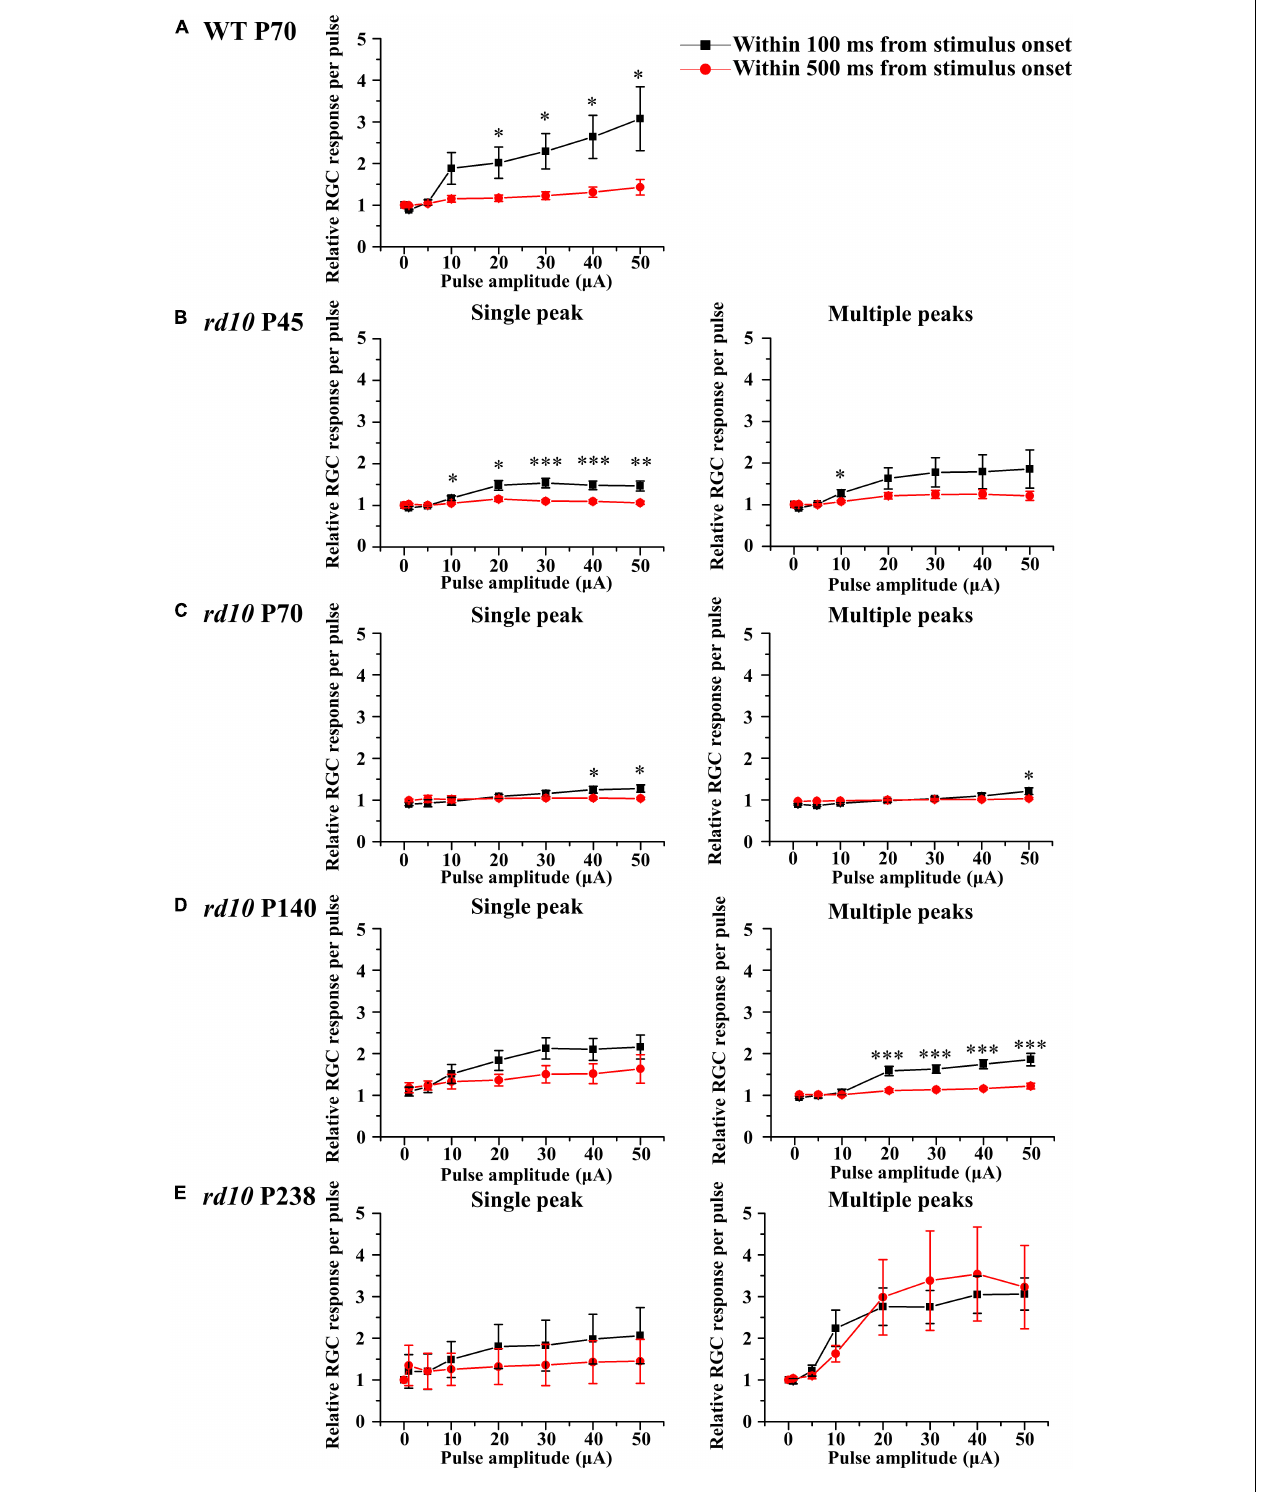
FIGURE 8 | The retinal ganglion cell (RGC) response curves to pulse amplitude modulation for a single peak (left column) or multiple peaks groups (right column). The RGC response curve plotted against pulse amplitude for the WT group at P70 (A) and rd10 groups at P45 (B) , P70 (C) , P140 (D) , and P238 (E) groups. Error bars represent the standard error of the mean (SEM). The curves drawn in black include the spikes within 100 ms after stimulus onset, and the curves drawn in red include the spikes within 500 ms after stimulus onset. Asterisks indicate statistical differences between 100 and 500 ms at each pulse amplitude (*** p < 0.001, ** p < 0.01, and * p <